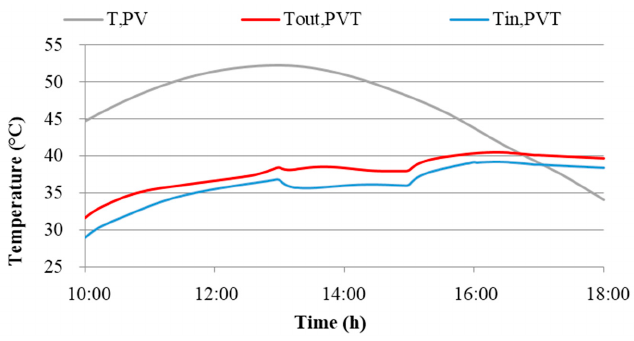
Figure 8. Summer day: inlet and outlet PVT collector temperature.